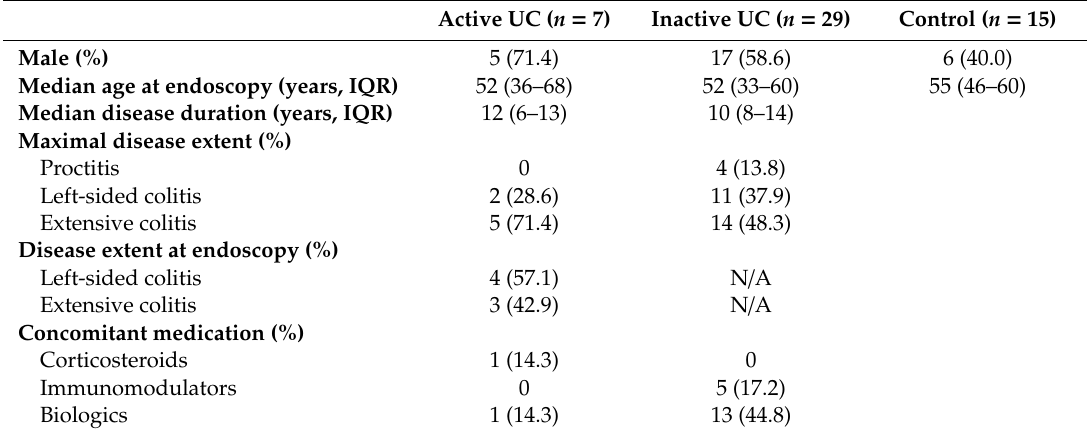
Table 1. Baseline